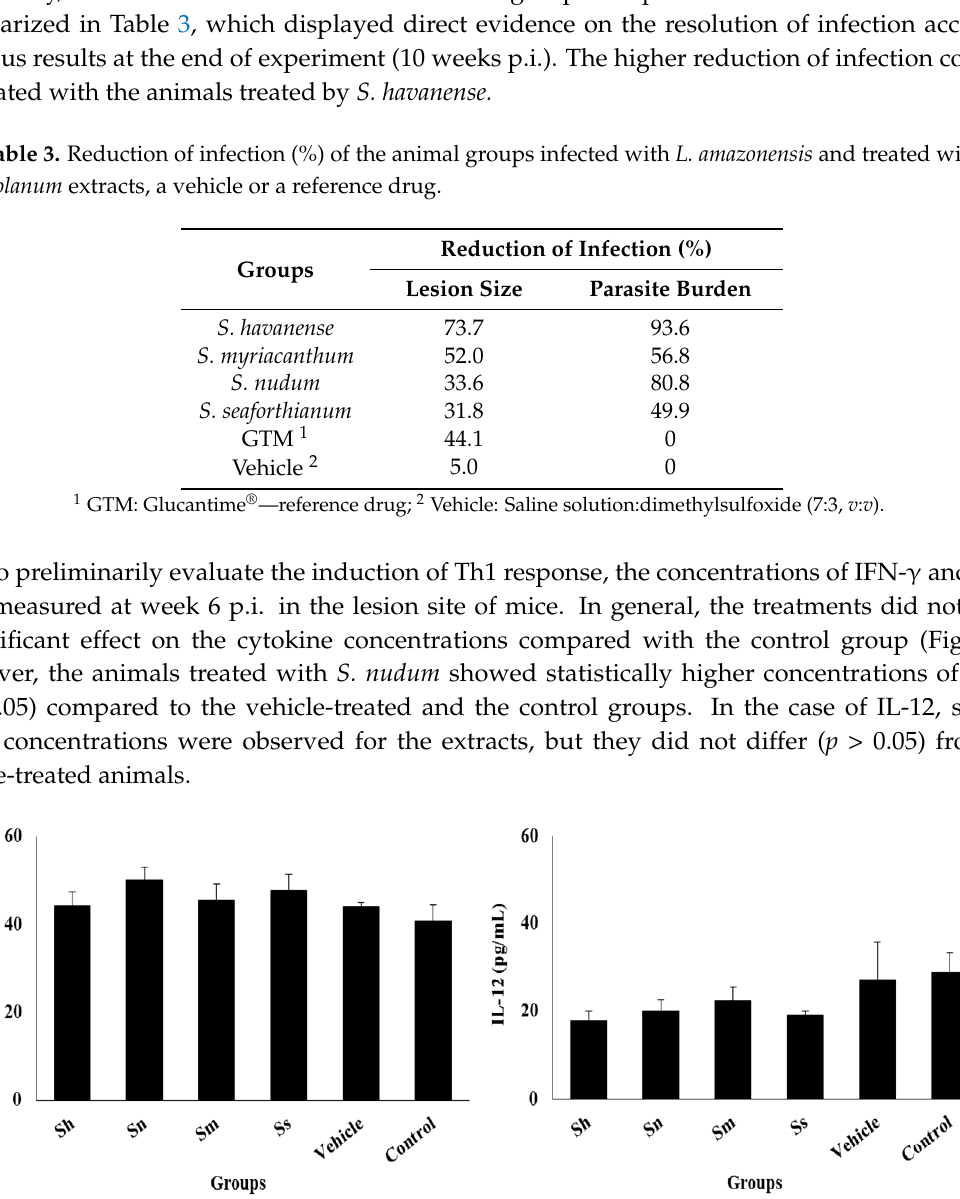
Figure 3. IFN- γ and IL-12 production in infected areas of BALB/c with L. amazonensis . The results were expressed as mean ± standard deviation. * Statistically significant difference ( p < 0.05) compared with the vehicle-treated and the control